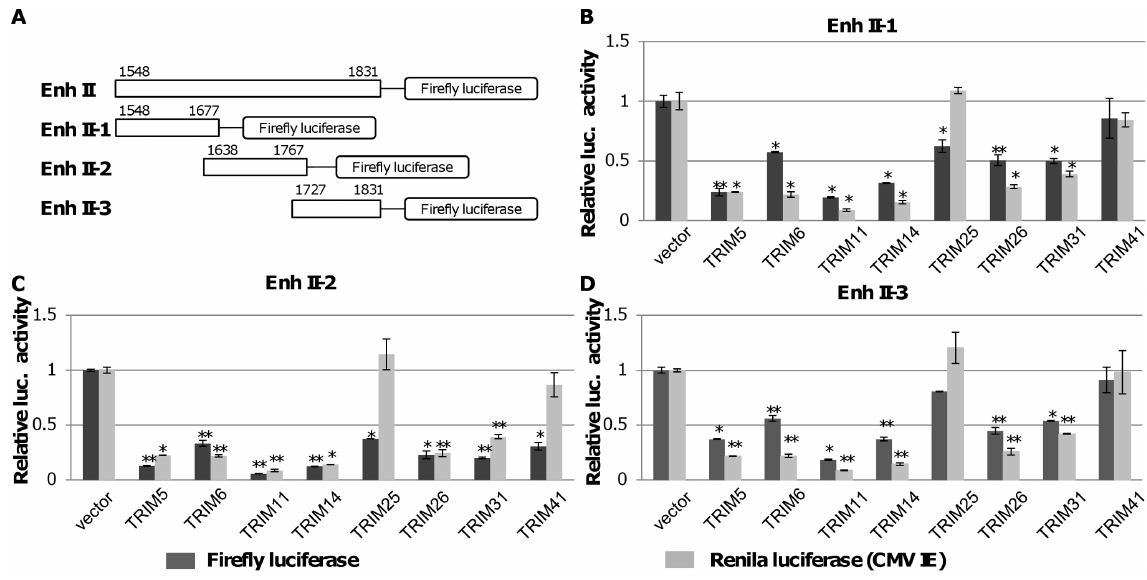
Figure 5. Mapping the cis element that mediates TRIMs inhibition of HBV Enh II activity. (A) Schematic representation to map the cis element mediating TRIMs inhibition of HBV Enh II activity. Three overlapping DNA fragments covering the entire HBV Enh II region were placed in the up-stream of a firefly luciferase coding sequence to yield three reporter plasmids, pGL4.10-HBV Enh II-1, pGL4.10-HBV Enh II-2 and pGL4.10-HBV Enh II-3, respectively. (B to D) 0.2 m g of the indicated reporter plasmid was co-transfected into HepG2 cells in 24 well plates with 0.2 m g of a vector plasmid or a plasmid expressing the indicated TRIM proteins, with 0.1 m g of pCMV-renilla luciferase as an internal control. Two days post transfection, cells were harvested and the luciferase activity was analyzed with a dual-luciferase kit. The mean and standard deviations (n=4) were presented. * and ** indicate P , 0.05 and 0.01, respectively.